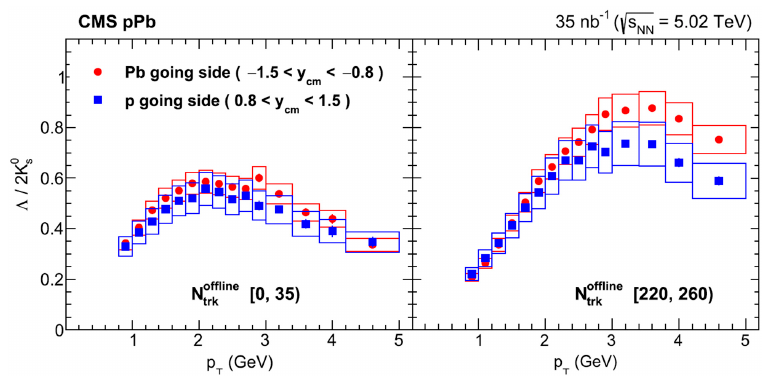
Figure 11. Ratios of p T spectra, in forward and backward rapidity regions in pPb collisions at √ s NN = 5.02 TeV. Results are presented for two particle multiplicity ranges; figure and details are taken from [27].